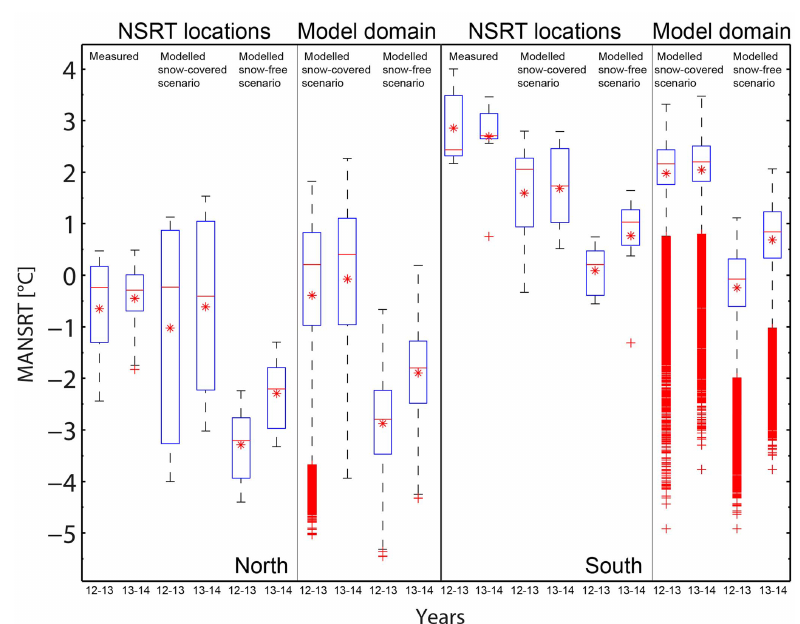
Figure 9. MANSRT variability within the individual N-facing (left) and S-facing (right) rock walls for the years 2012–2013 (12–13) and 2013–2014 (13–14). The MANSRT variability in the rock walls was based on 22 measured NSRTs, 11 facing N and 11 facing S. Measured MANSRT variabilities are compared to modelled MANSRT differences calculated at the grid cells of NSRT locations, shown for both the snow-covered and the snow-free scenarios. In addition to the MANSRT differences calculated at all 22 NSRT locations, the modelled MANSRT variability of each grid cell of the entire model domain is shown, depending on whether the grid cell is N- or S-facing. The median is marked with a red horizontal line in each box, the mean is additionally plotted as a red asterisk, the box edges are the 25th and the 75th percentiles, the whiskers extend to the 2.5 and 97.5% quantiles and outliers are plotted as individual